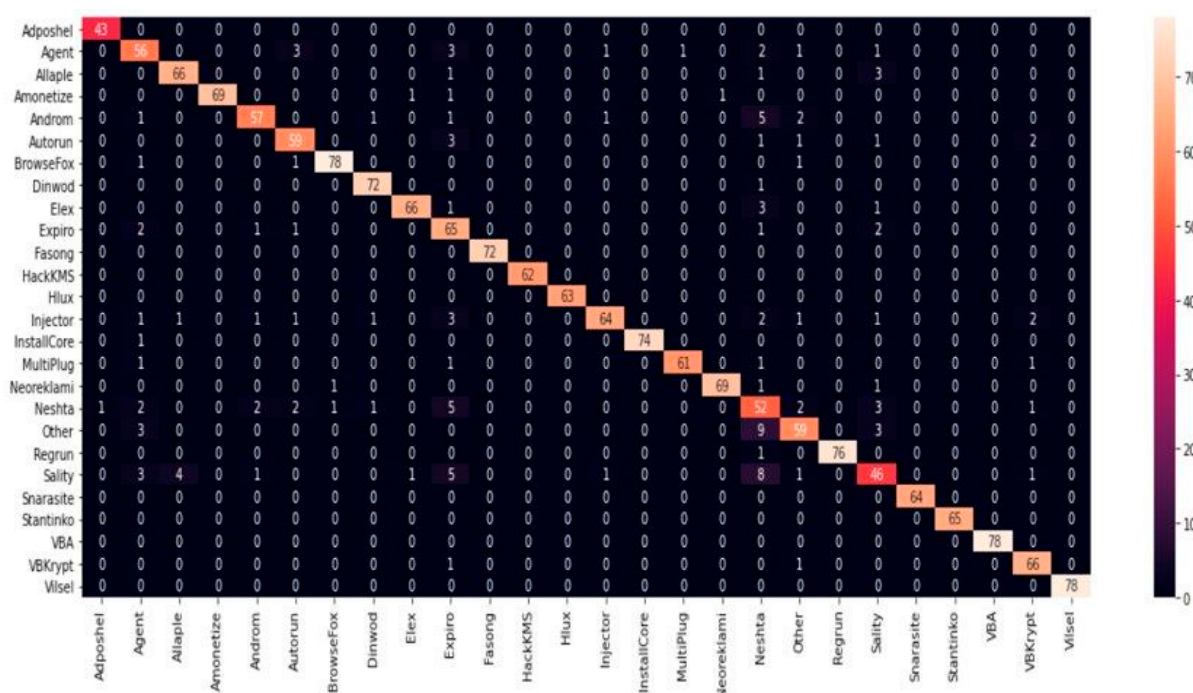
Figure 14. Training and testing loss of CNN. 3.